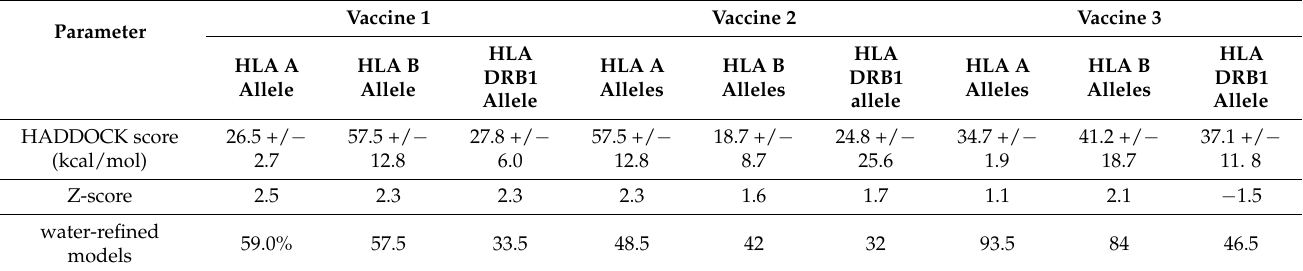
Table 4. Static interaction parameters of HLA A alleles, HLA Balleles, and HLA DRB1 allele with vaccines 1, 2, and 3. Vaccine 1 Vaccine 2 Vaccine 3 Parameter